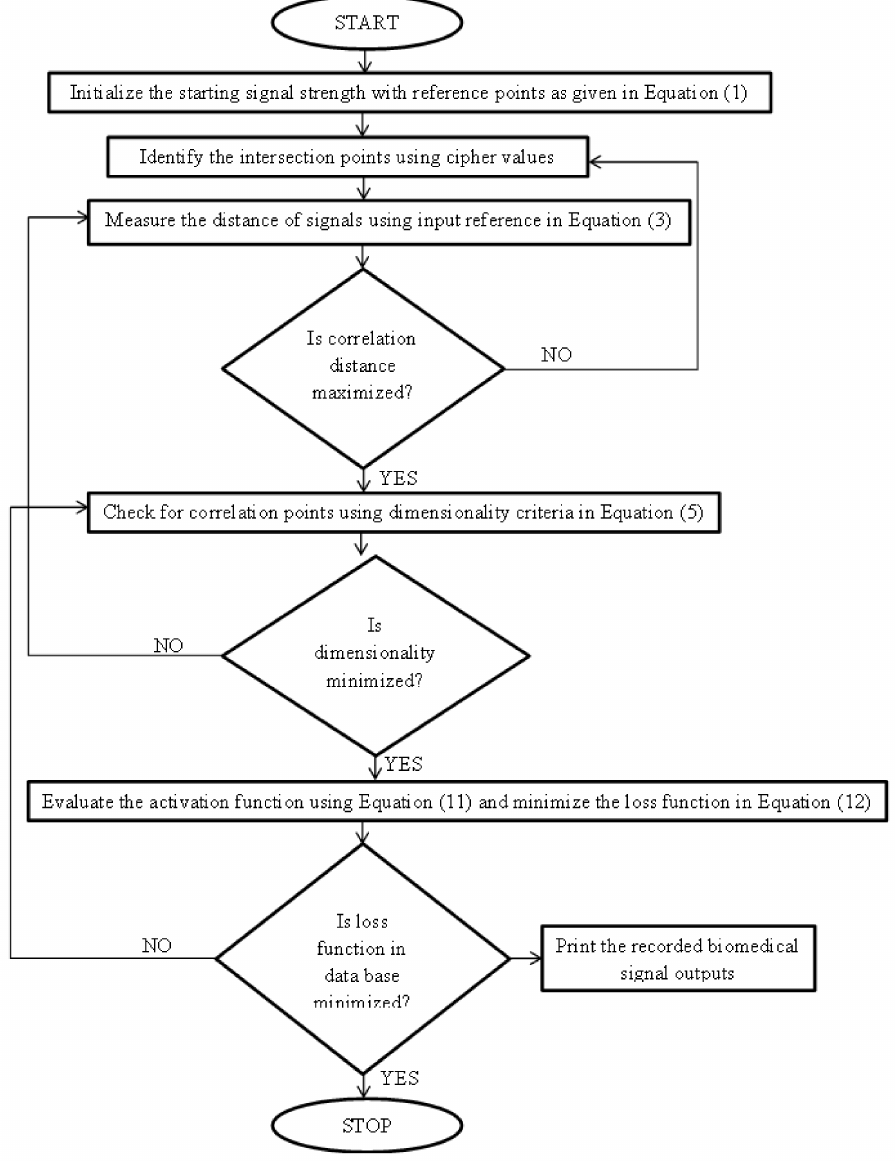
Figure 2. Fuzzy intelligence system for biomedical signal